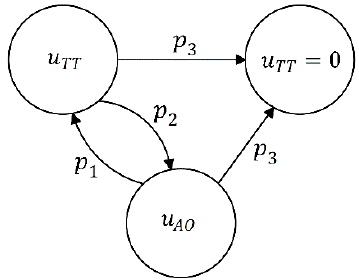
Figure 3. Switch strategy of the proposed control system.